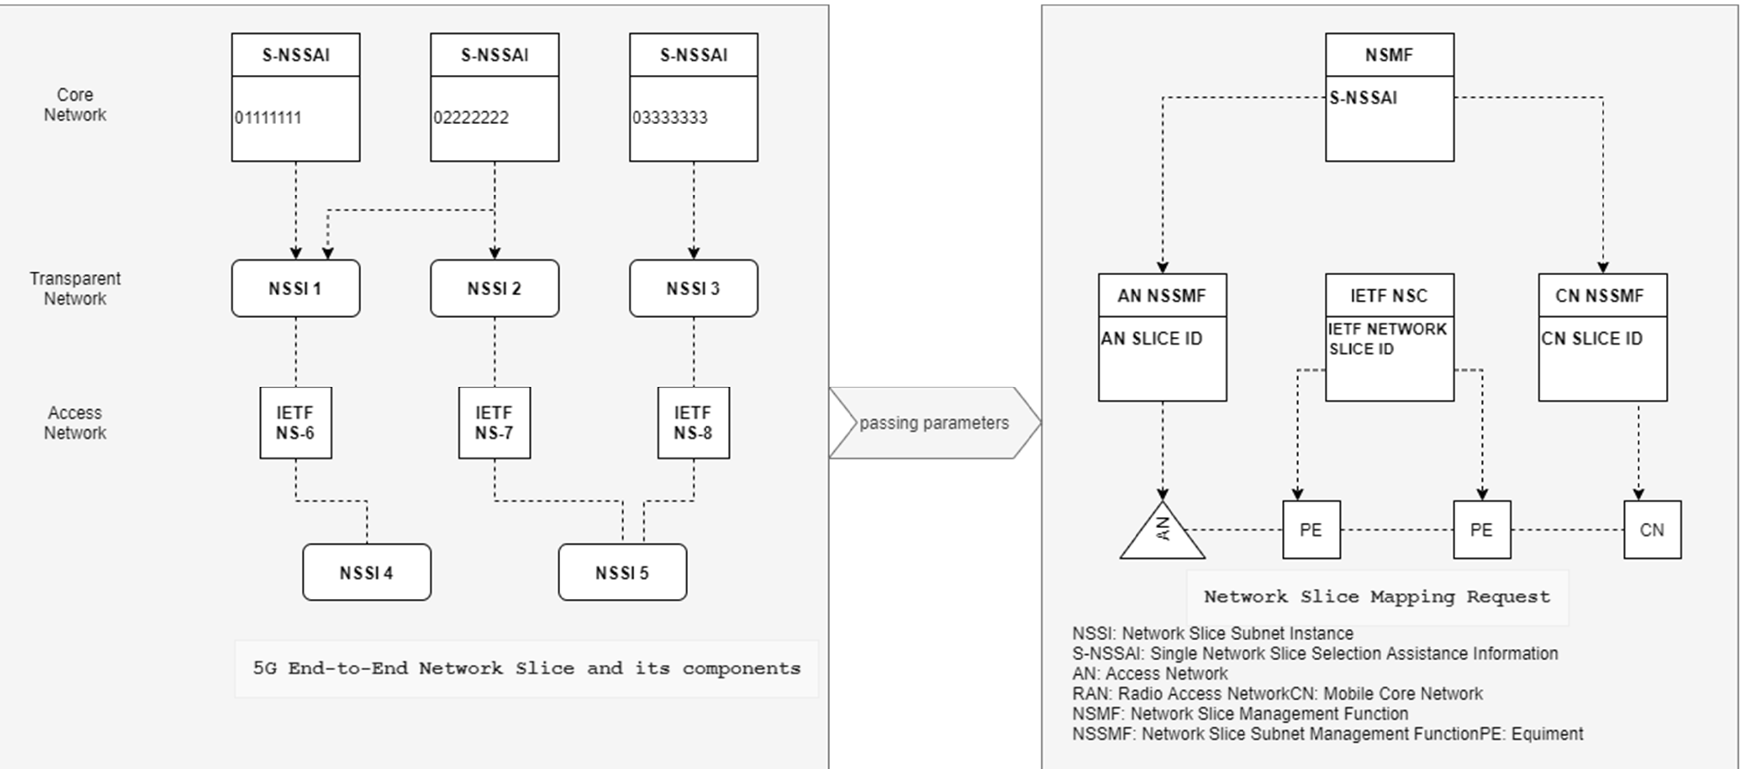
Figure 5. Network slice mapping structure for 5G.